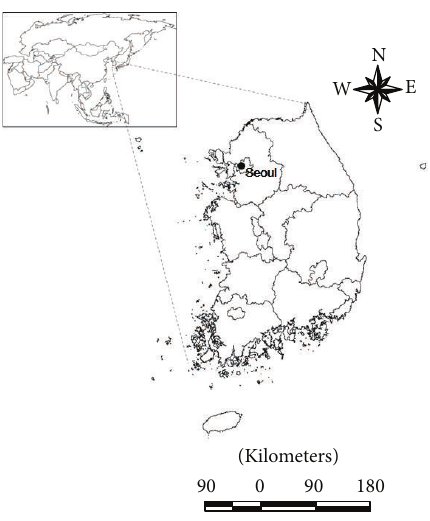
Figure 1: The location of Seoul weather station, Korea.